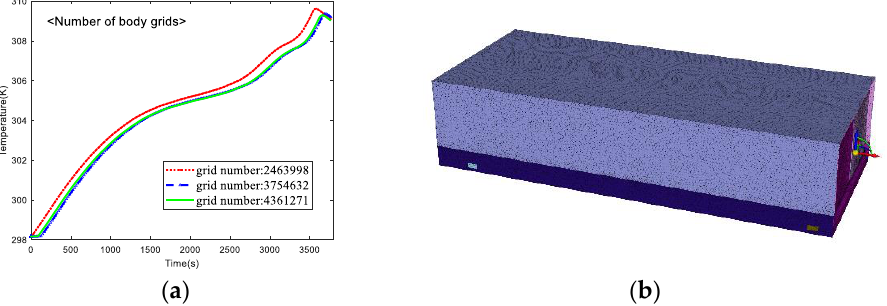
Figure 3 . ( a ) Calculation results using different number of grids in the same time period. ( b ) Sche- matic of the grid structure of the cell